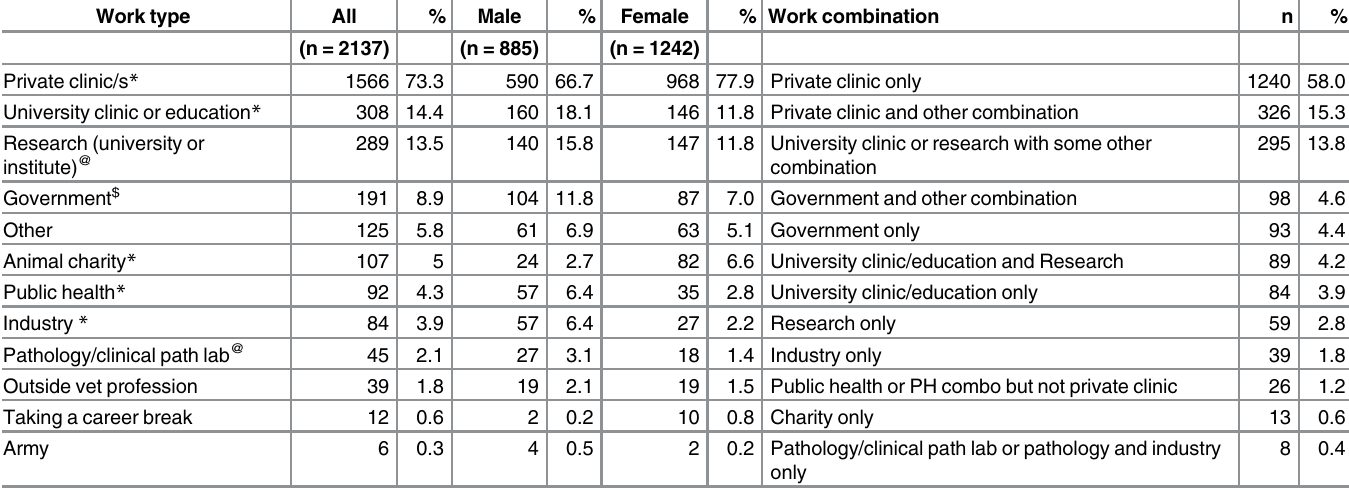
Table 3. Work type and combinations of work types of all respondents (n =